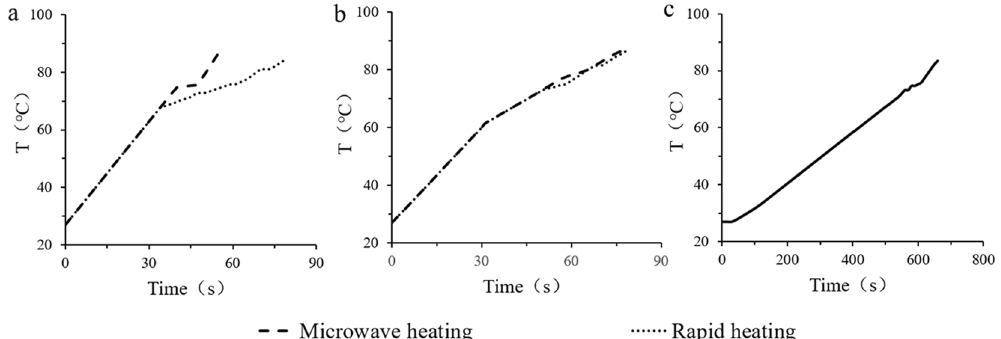
Figure 2. Temperature curves of the samples treated with three different heating methods. ( a ) Temperature curves of the samples treated with microwave heating (1200 W) and rapid conventional heating. ( b ) Temperature curves of the samples heated using microwave heating (1200 W × 32 s, 600 W × 20 s, 300 W × 14 s, 600 W × 12 s) and rapid conventional heating. ( c ) Temperature curves of the samples treated using conventional